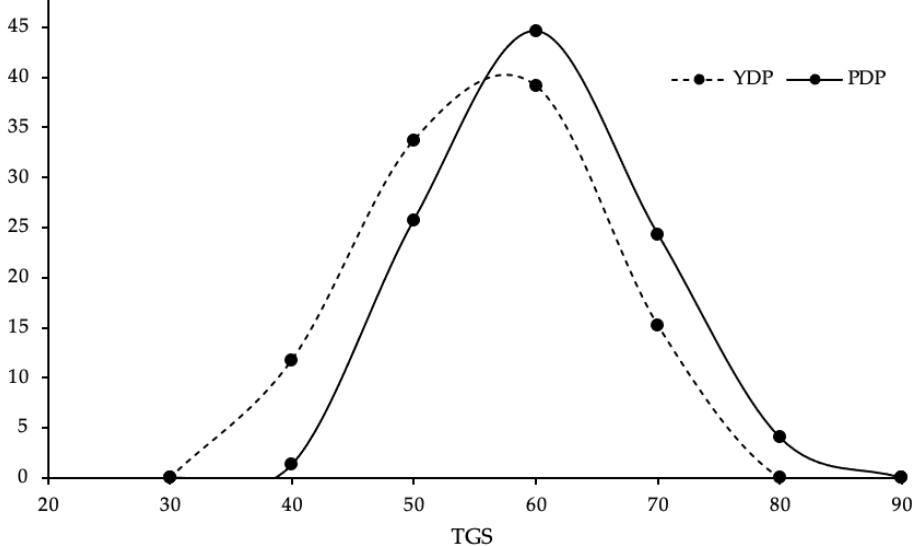
Figure 2. Frequency distribution of total genotype score (TGS) in youth development phase (YDP) and professional development phase (PDP) English academy football players. The TWGS of players ranged from 31 to 74 in the YDP group and 24 to 78 in the PDP group (see Figure 3). The mean TWGS of PDP players (56.5 ± 9.63) was significantly higher than YDP players (50.0 ± 9.54; t (164) = 4.34, p < 0.001). The YDP tertile distribution was: lower = 39, middle = 29, and higher = 24, whereas the PDP tertile distribution was: lower = 11, middle = 24, and higher = 39. Compared to YDP players, PDP players had 5.76 times the odds of having a TWGS in the higher third (i.e., 57–78) than a TWGS in the lower third (i.e., 24–48; OR = 5.76, CI: 2.49–13.35), as well as 2.93 times the odds of having a TWGS in the middle third (i.e., 49–56) than a TWGS in the lower third (OR = 2.93, CI: 1.24– 6.94). The ROC analysis determined that TWGS frequency distribution showed significant, but poor, discriminatory power in distinguishing YDP and PDP players (AUC = 0.694, 95% CI: